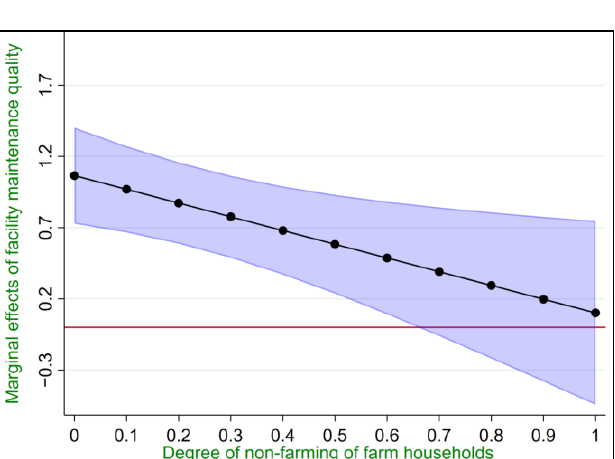
Figure 5. Moderating effect of the degree of non-farming of farm households on the quality of facility maintenance. Note: The black line in the figure indicates the moderating effect of the degree of non-farming of farm households on the quality of facility maintenance affected by property rights reform. The blue area represents the 95% confidence interval. The red line in the figure represents the significance level.